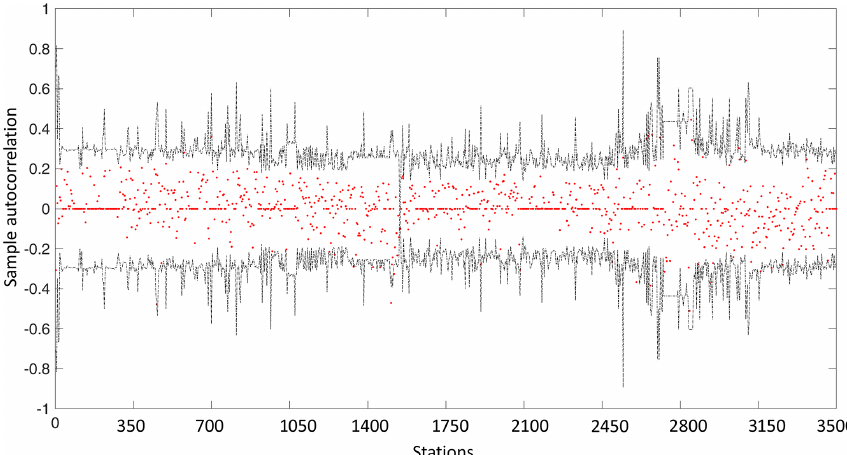
Figure 3. Sample autocorrelations. The red points are the value of the lag-1 autocorrelation coefficient, whereas black dotted lines represent the 95% confidence